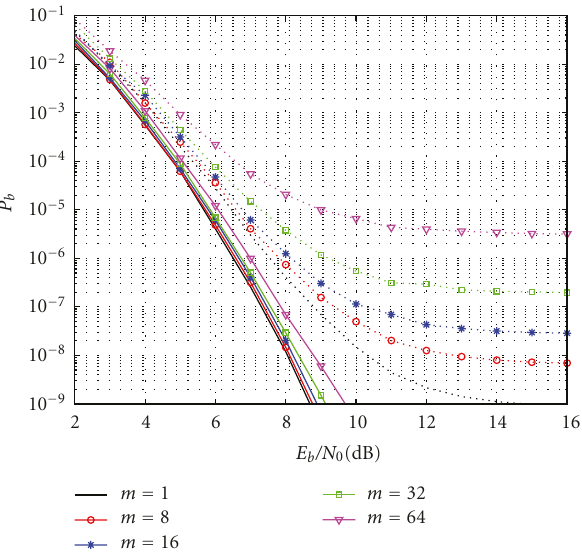
Figure 7: Performance of a convolutionally coded FHSS system over a Rician fading with κ = 10 dB and perfect CSI for di ff erent hop lengths m and SIR = 5dB, (solid: K = 1, dashed: K = 40).